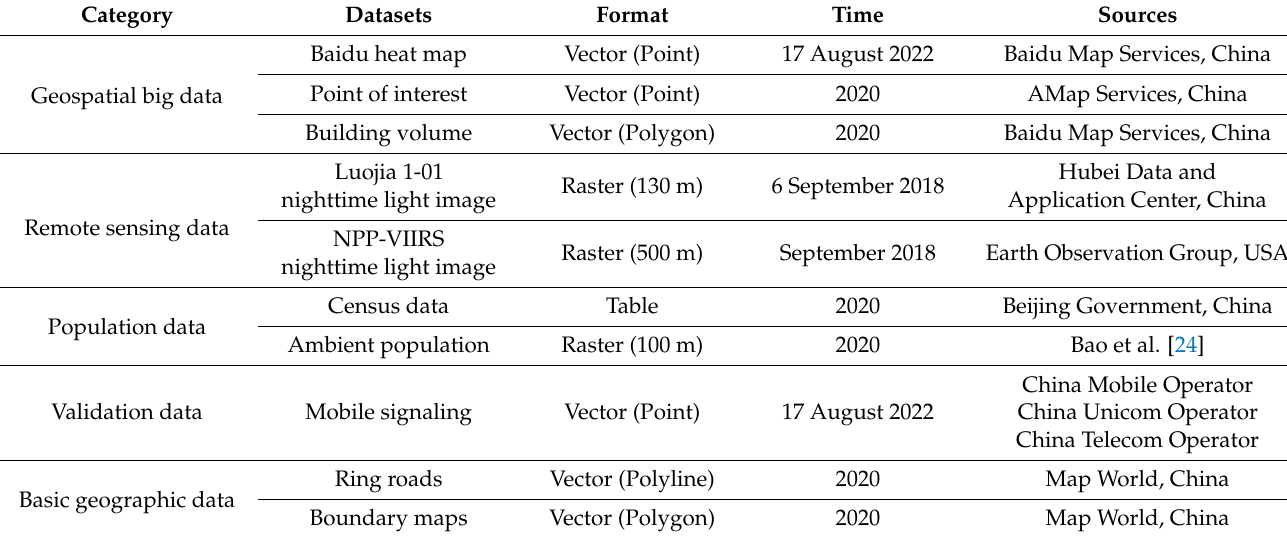
Table 1. List of datasets and sources used in the study.